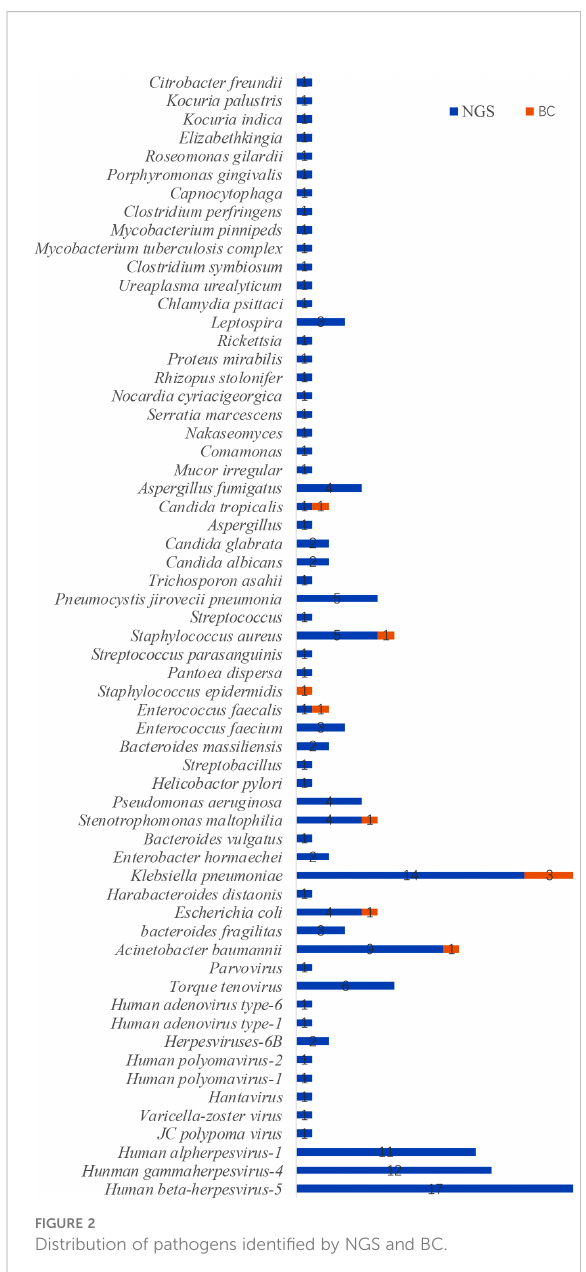
FIGURE 2 Distribution of pathogens identi fi ed by NGS and